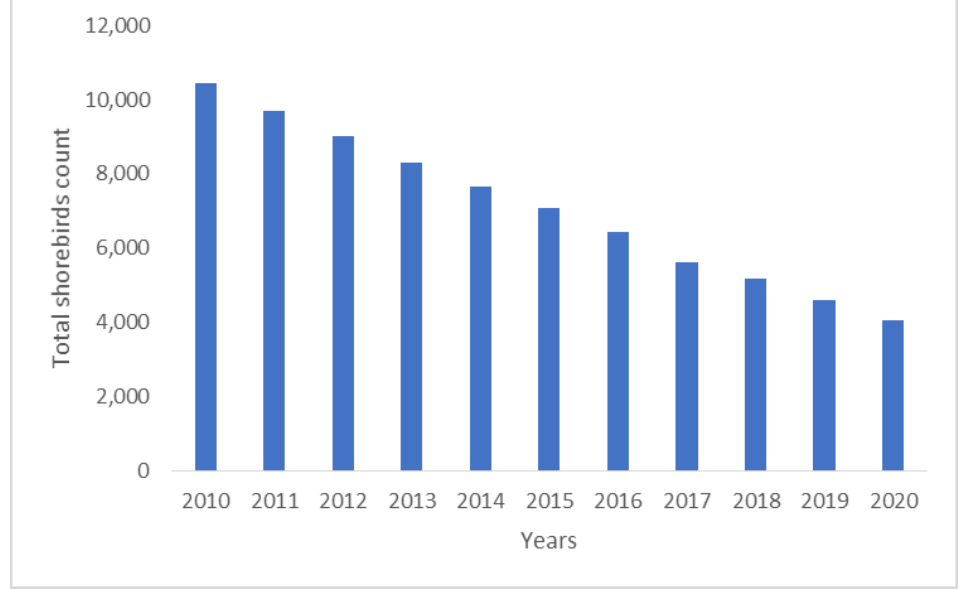
Figure 5. Variation in shorebirds’ count over years at Gulf of Mannar, east coast of India — H. Byju, unpublished data.